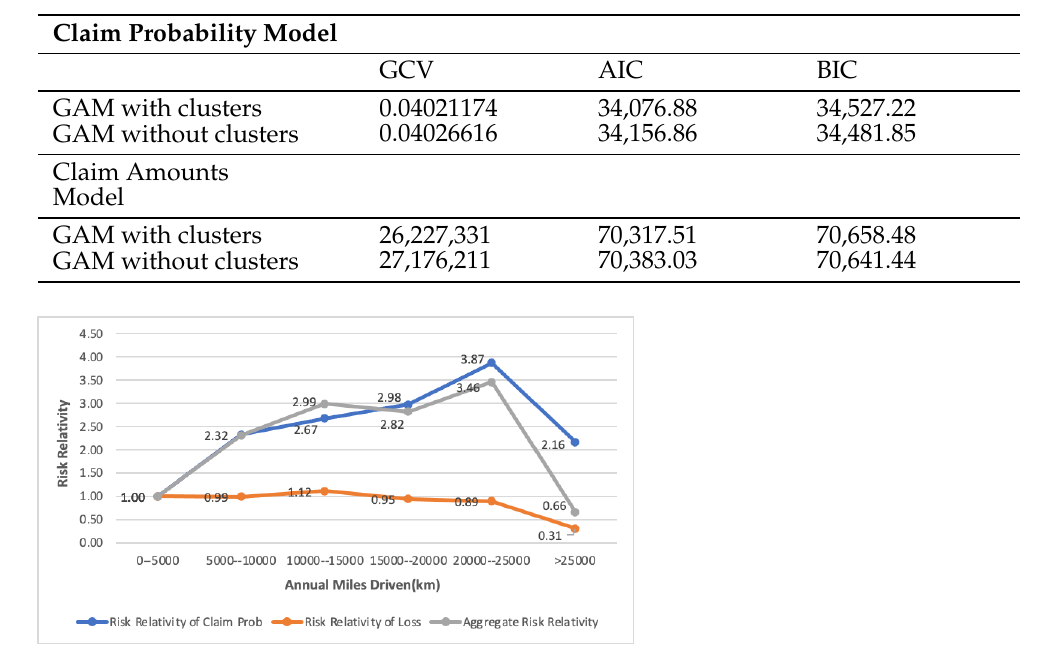
Table 8. Performance comparison between GAM models for predicting claim probability and claim amounts, respectively. Note: GCV: Generalised Cross-Validation Statistic; AIC: Akaike Information Criterion; BIC: Bayesian Information Criterion.